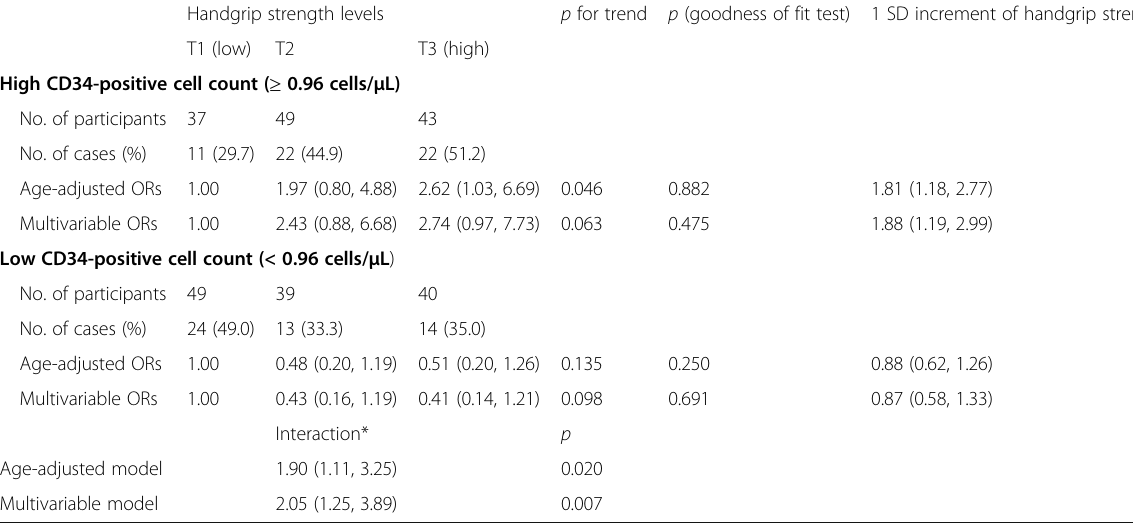
Table 3 Odds ratios (ORs) and 95% confidence intervals (CIs) for systolic hypertension in relation to handgrip strength stratified by circulating CD34-positive cell count Handgrip strength levels